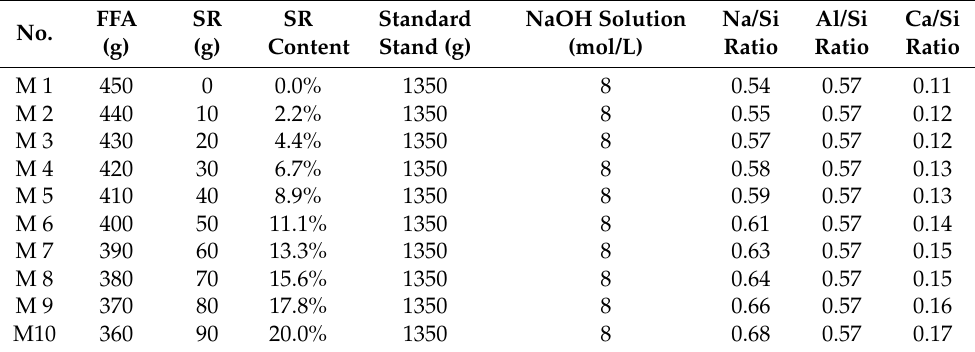
Table 3. Mixing proportions of the geopolymer mortars prepared at room temperature. Liquid–solid ratio is 0.75, and cement–sand ratio is